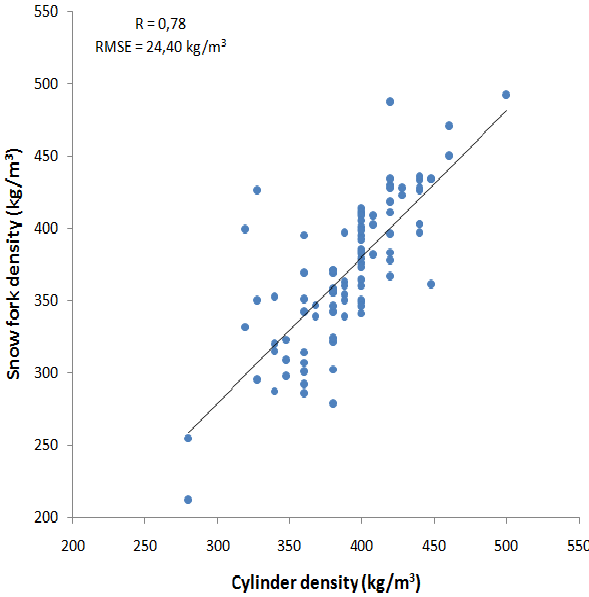
Fig. 2. Comparison of snow density measured using the cylinder and snow fork. The data include 93 simultaneous measurement pairs from the same depth in the uppermost 0.5m